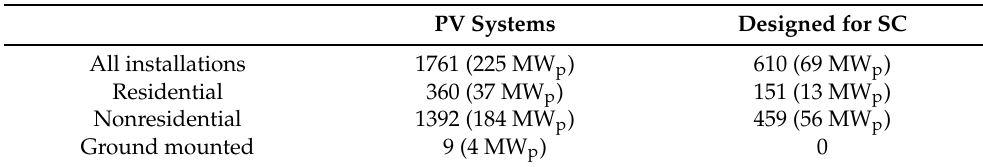
Table 4. Composition of the SOL systems portfolio for time series validation with the number of PV systems (total nominal power in parentheses) by type of installation and information on self-consumption